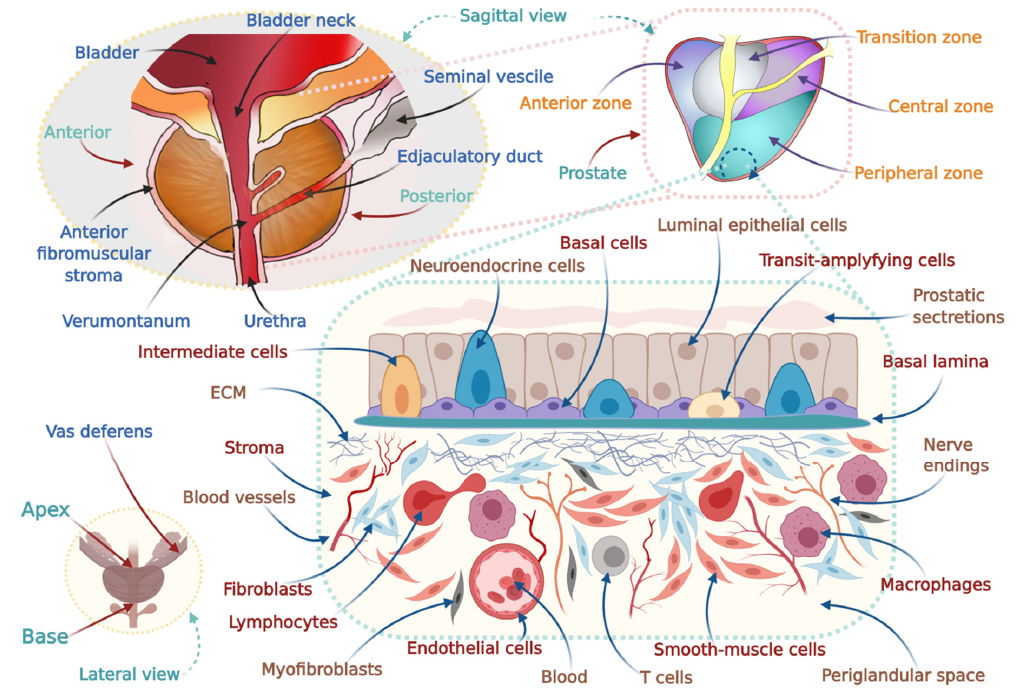
Figure 4. Schematic of the human prostate anatomy and cellular components within the prostate gland: The prostate, a fibromuscular glandular organ related to the male reproductive system located below the bladder with an apex, a base, a posterior, an anterior, and two lateral surfaces, is composed of 3 distinct zones having histological differences. The peripheral zone (PZ) is positioned at the posterior side constituting around 70% of the gland and is identified as the zone from where most (~75%) prostatic intraepithelial neoplasia (PIN) and carcinomas originate. Constituting 25% of the gland, the central zone (CZ) includes the ductal tube coming from the seminal vesicle to the point where it connects to the descending urethra. Cancer arising from CZ is about 5% of total prostate cancers. The transitional zone (TZ) represents roughly 5–10% of the gland, and is immediately below the bladder and encircles the transitional urethra. Approximately 20% of prostate cancers stem from TZ, which is also the region from which benign prostatic hyperplasia (BPH) develops. The normal functioning of the prostate depends mainly on the androgen, testosterone, produced by the Leydig cells within the testes and adrenal glands (i.e., androgen dependent). Dihydrotestosterone (DHT), the active metabolite of testosterone produced by prostate cell membrane 5 α -reductase isoenzymes, binds to androgen receptors (i.e., adrenoceptors) to conduct signaling pathways that involves tissue and organ regulatory effects. Several cell types including basal, luminal, and neuroendocrine cells, and two in-between phenotypes (transit-amplifying cells, which are more basal-like phenotype non-secretory cells, and intermediate cells, which are more luminal-like phenotype secretory cells), are the main components of the epithelial compartment. Epithelial tissue is backed by a stroma consisting of extracellular matrix (ECM), blood vessels, immune system cells, nerve fibers, and stromal cells such as fibroblasts, myofibroblasts, and smooth muscle cells (most abundant). The stroma or periglandular space acts as the boundary of the gland. High levels of androgen receptors (AR) are expressed in the secretory columnar shaped cells called luminal cells, and can be considered the major prostate or epithelial cell type because it forms the exocrine compartment that is involved in the secretion of prostate-specific antigen (PSA) and prostatic acid phosphatase (PAP) into the acinar lumen. The non-secretory cuboidal shaped cells having low or undetectable AR located along the basement membrane are known as basal cells. Neuroendocrine cells are non-secretory, differentiated, androgen-insensitive cells that express CD56, chromogranin A (CgA), synaptophysin, neuron specific enolase (NSE) and neuropeptides (e.g., bombesin, calcitonin, and neurotensin) and are rare (~1% of the epithelium). The apex is aimed downward and connects with the superior fascia of the urogenital diaphragm. The base is aimed upward close to the bladder’s inferior surface, and it is partly continuous with the bladder wall. Adopted from Refs.